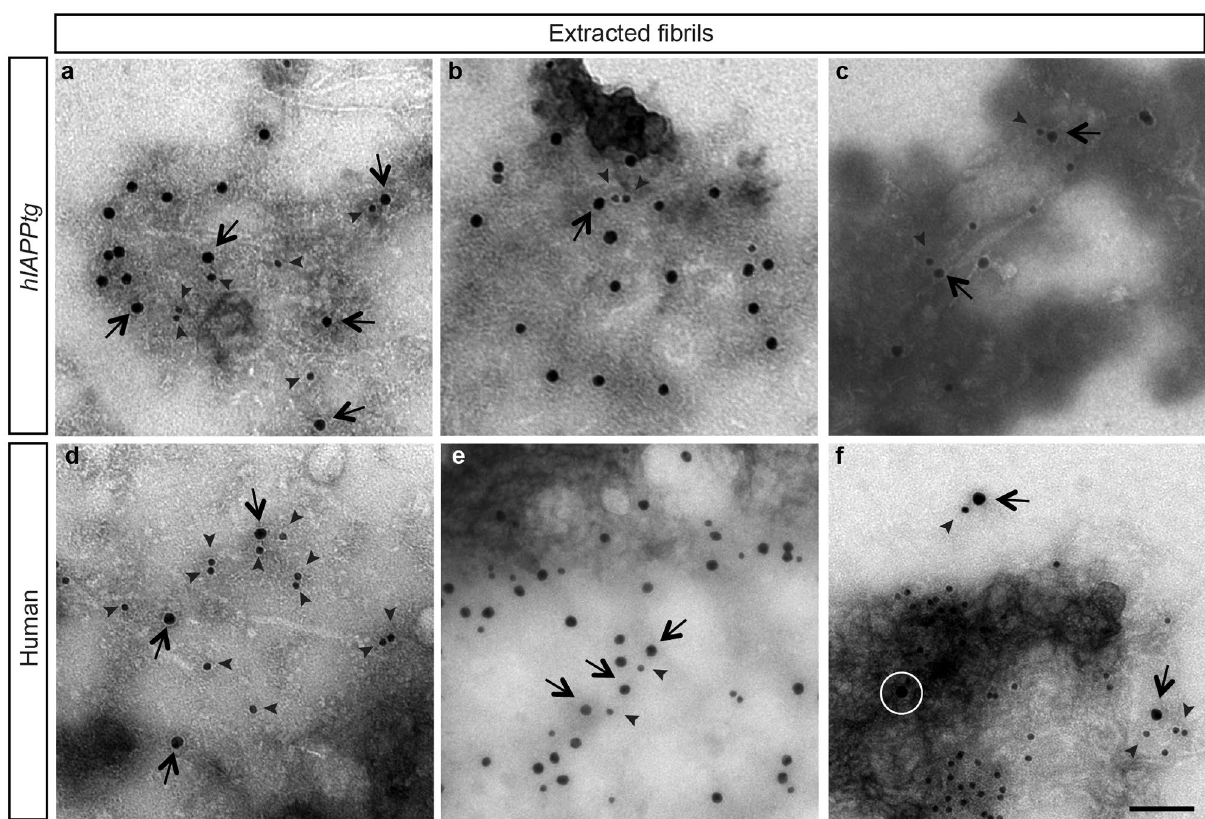
Figure 1. αSyn and IAPP co-localize in mouse and human islet amyloid. (a-f) TEM images of fibrils extracted from 3 independently pooled hIAPPtg mouse pancreases, 2 pooled pancreases/extract, (a-c), and human islets (d-f) (donors #4, 5, and 6 from left to right) showing immuno-gold labelled αSyn (sc-7011R, 15 nm gold particles) and IAPP (NBP1-06579, gold 10 nm gold particles). Black arrows and white circle indicate αSyn and arrow heads indicate IAPP labelled gold particles. Scale bar is 100 nm in ( a–f)